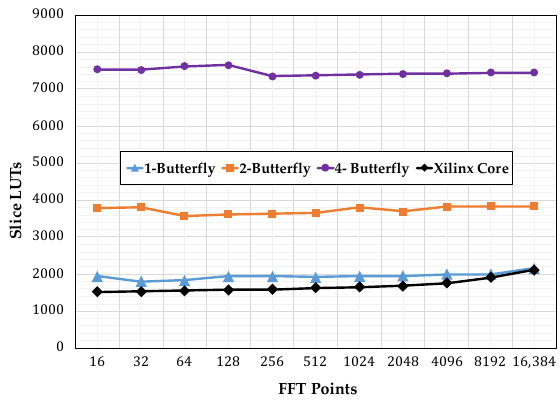
Figure 12. Slice look up tables (LUTs) consumption comparison.